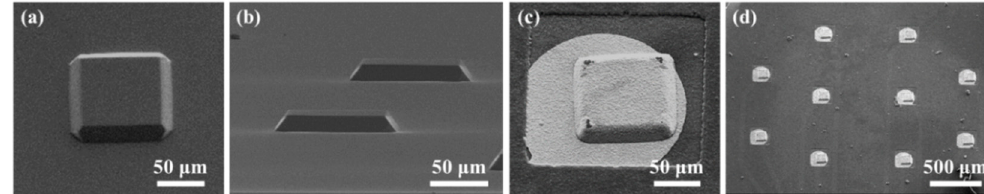
Figure 3. SEM images of fabricated convex structures. ( a ) Top view of a PDMS convex structure. ( b ) Side view of the PDMS convex structures. ( c ) Top view of an electrode site having a PDMS/parylene/metal hybrid convex structure. ( d ) Top view with different magnification of the electrode sites. Some images were adapted and modified from a doctoral dissertation [25,26].